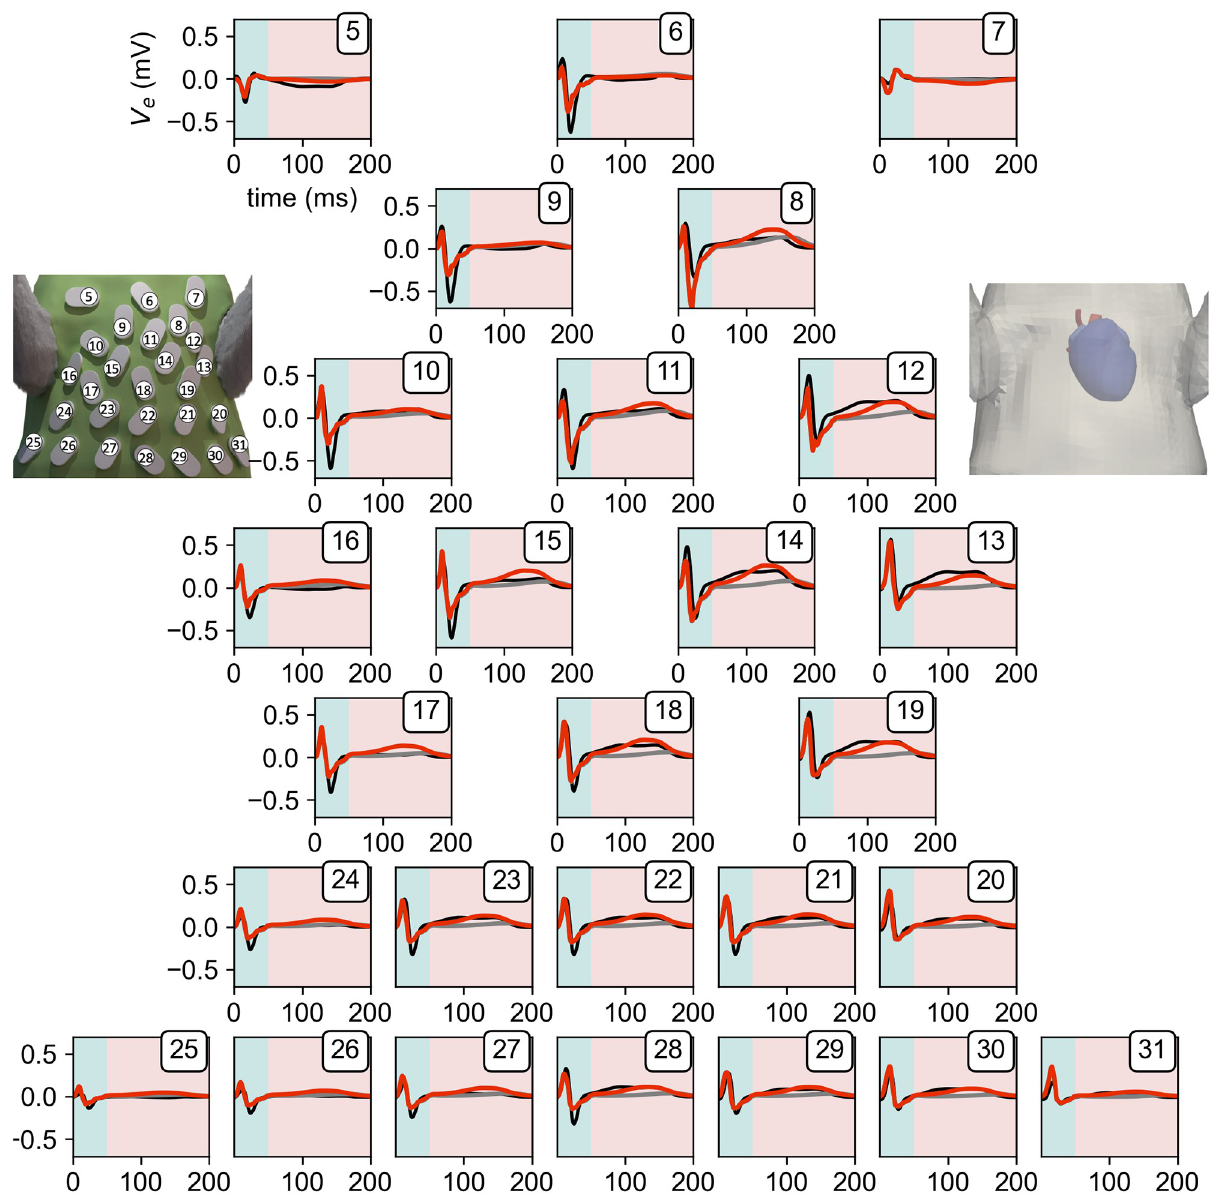
Fig 9. Resulting measured and simulated lead signals. Measured (black), simulated without any gradient (gray), and best simulated gradient (red) signal of body surface potential traces for Lead 5 – Lead 31 ( Lead 1 – Lead 4 , Lead 32 not shown). The simulated traces where scaled as described in the methods section. Turquoise background indicates the QRS-Complex (1–50 ms) and salmon the T-Wave (50–200 ms). Each subplot is labeled by the respective lead number on the top right corresponding to its placement seen in the left image of the ECG-vest. The displayed simulated trace incorporates a gradient in APD of a shortening towards the apex of 20 ms and a shortening towards the epicardium of 15ms. This results in an overall average RMSE of the leads during the QRS-Complex of 0.074 mV/ms and 0.038 mV/ms during the T-Wave